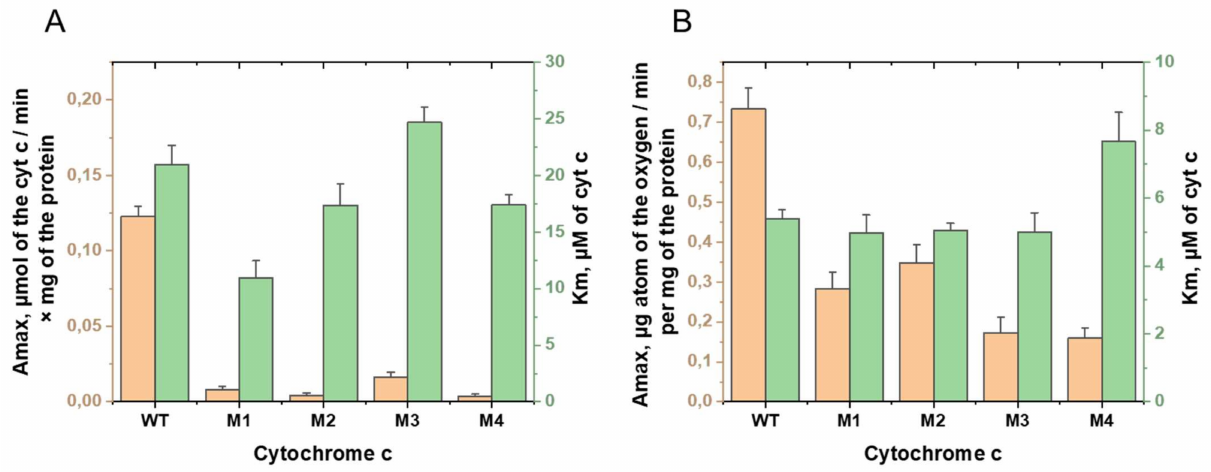
Figure 1. Comparison of the kinetic parameters A max (orange columns) and K m (green columns) of the ( A ) succi- nate:cytochrome c -reductase and ( B ) cytochrome c -oxidase reactions in rat liver mitoplasts in the presence of the externally added WT and mutant cytochromes c T78N/K79Y/M80I/I81M/F82N (M1), T78S/K79P (M2), I81Y/A83Y/G84N (M3), and P76I/G77L/I81L/F82L